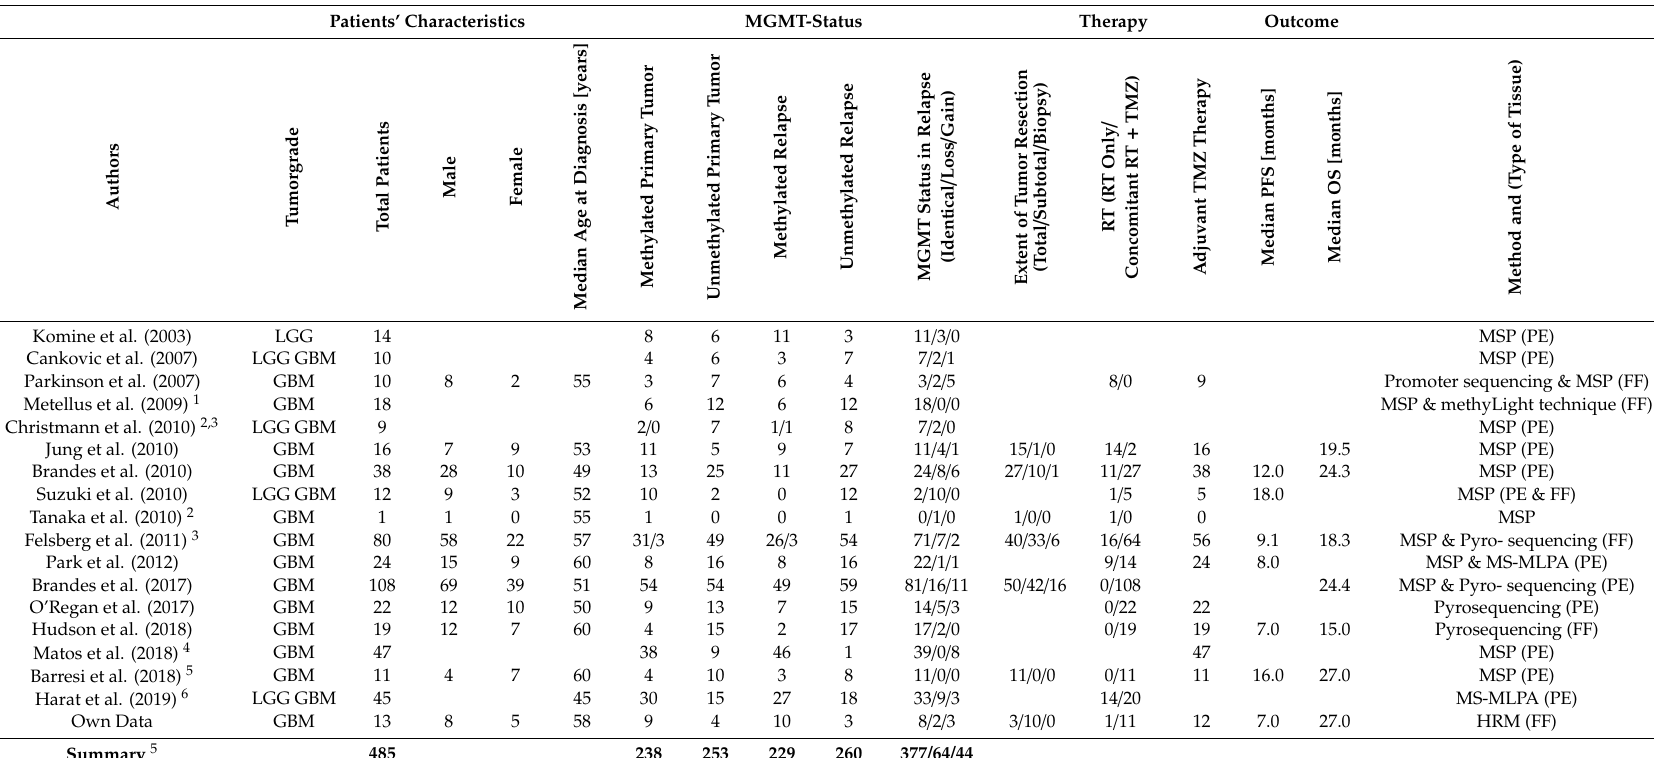
Table 2. Summary of publications presenting GBM patients with changes in MGMT promoter methylation in